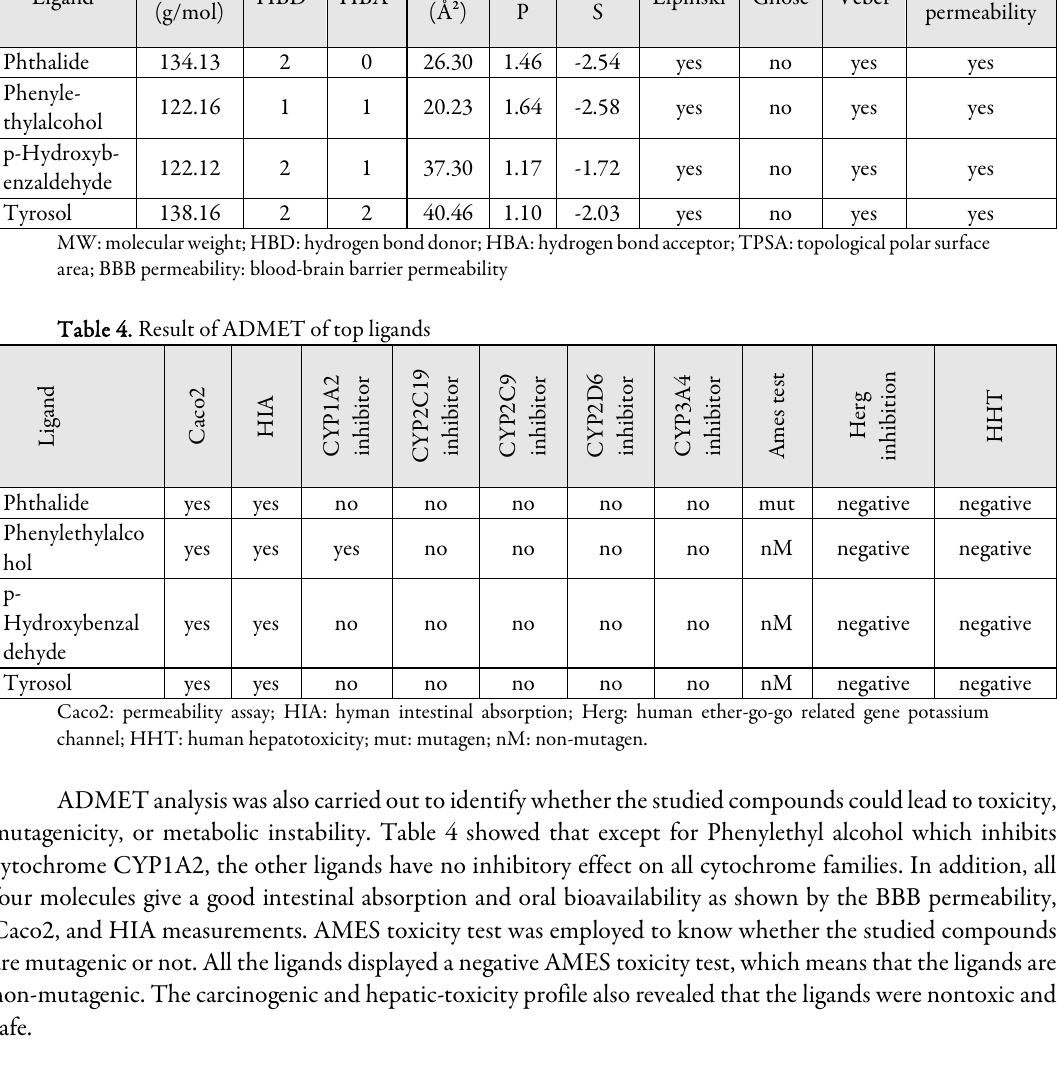
Table 3. Result of drug-likeness of the top ligands Ligand